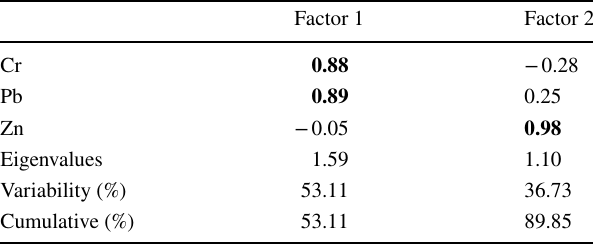
Table 4 Factor loading for metal after varimax rotation using princi- pal component